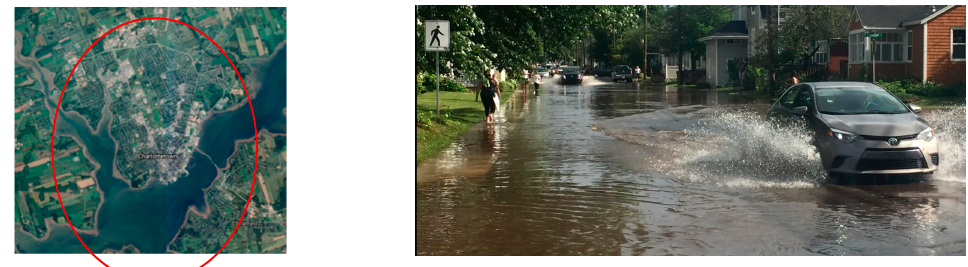
Figure 6. A Google Earth view of Charlottetown area reflecting potential for a storm water of the city to go to the harbor ( left ), by routine, backs up into the city system as a result of water coming in from the tide (source for ( right ): a photo from the CBC online news published on 10 August 2018 at https://www.cbc.ca/news/canada/prince-edward-island/pei-charlottetown-heavy-rain-flooding-wat er-1.4781688).